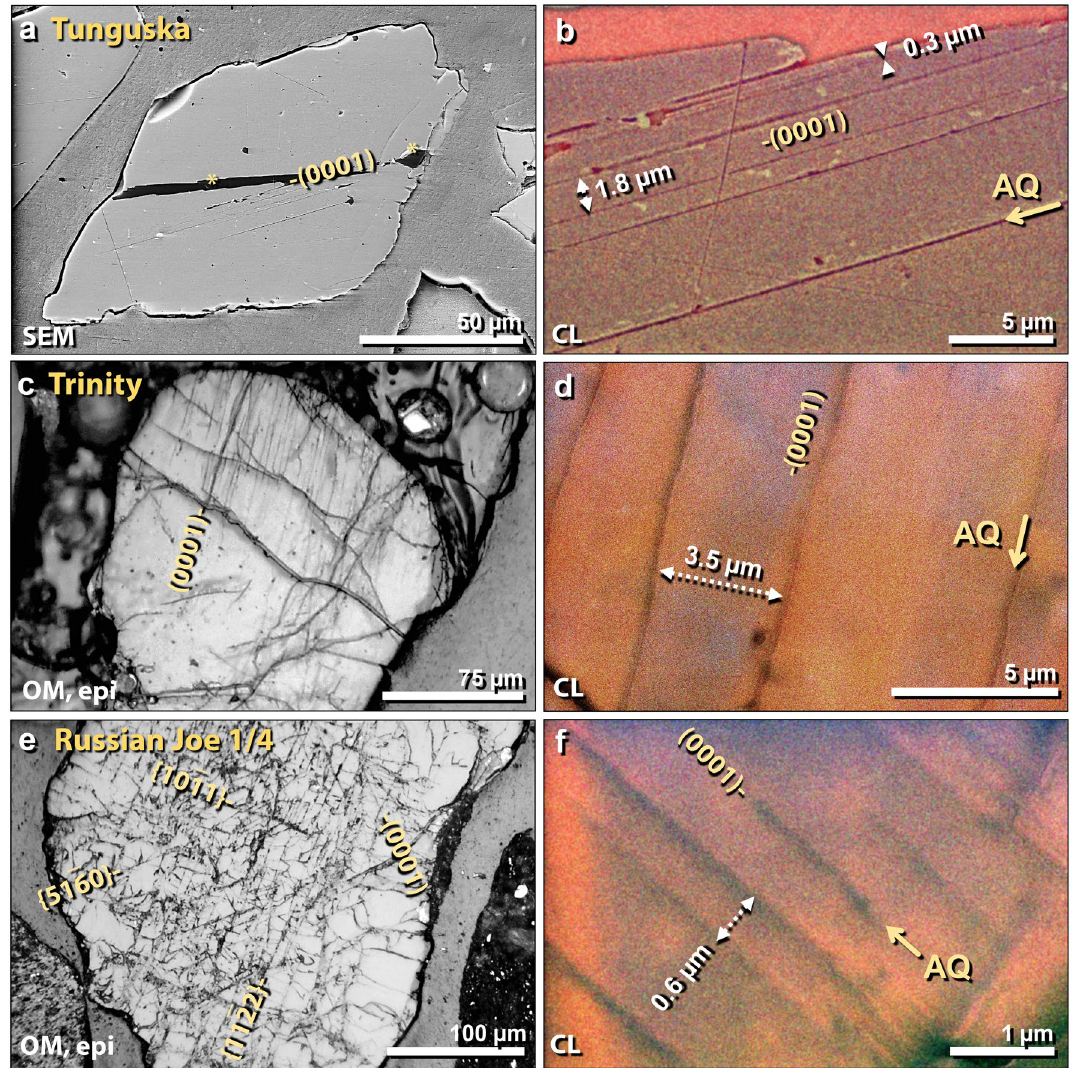
Figure 21. Shocked quartz from known airbursts. ( a ) SEM image of 140-µm-wide shocked quartz grain from Tunguska airburst. Discontinuous lamellae formed along the (0001) plane. ( b ) Close-up SEM-CL image of same grain as in panel ‘ a ’. Lamellae spacing ranges from ~ 0.3 to 5 µm. Black lamellae indicate amorphous quartz (AQ). ( c ) Epi-illumination photomicrograph of 240-µm-wide shocked quartz grain embedded in trinitite that was ejected ~ 400 m from ground zero of the Trinity detonation. Discontinuous, sub-planar, sub-parallel lamellae are oriented along the (0001) plane. ( d ) Close up SEM-CL image of same grain as in panel ‘ c ’. Lamellae spacing ranges from ~ 2.5 to 6.5 µm. Black lamellae indicate amorphous quartz (AQ). ( e ) Epi-illumination photomicrograph of 520-µm-wide shocked quartz grain from Russia’s Joe-1/4 nuclear detonations; displays discontinuous sub-planar, sub-parallel micro-fractures and lamellae, just as reported for impact-shocked grains in the Charlevoix crater 56 . There are four sets of lamellae, one of which is oriented parallel to the (0001) plane. ( f ) Close up SEM-CL image of same grain as in panel ‘ e ’. Lamellae spacing ranges from ~ 0.3 to 1.3 µm. Black lamellae indicate amorphous quartz tion in Kazakhstan. Joe-1 (RDS-1) in 1949 is estimated at 20 kilotons TNT equivalent at 30 m elevation 66 , and Joe-4 (RDS-6) in 1953 is estimated at 400 kilotons at an altitude of 400 m 66 . Samples included an undifferentiated mix of materials from both detonations. We searched for potential shock lamellae in grains in ~ 2000 thin-sectioned quartz grains from each of the three sites and observed approximately 1 shocked quartz grain per 500–1000 grains, similar to the results for TeH. At all three sites, a small number of shocked quartz grains appear to have been ejected from ground zero and mixed with numerous unshocked detrital grains. As with impact-related PDFs, the lamellae commonly appear as one or more sets that are closely spaced (2–10 µm), narrow (< 2 µm), and range from curved to straight and parallel to subparallel (Fig. 21). The lamellae in grains from all of these sites match 17 features of impact-shocked quartz (Table 2). Most importantly, the TeH grains pass four main tests that confirm impact-shocked lamellae and contra-indicate tectonic lamellae: (i) they are crystallographically aligned; (ii) some are parallel to the c axis;